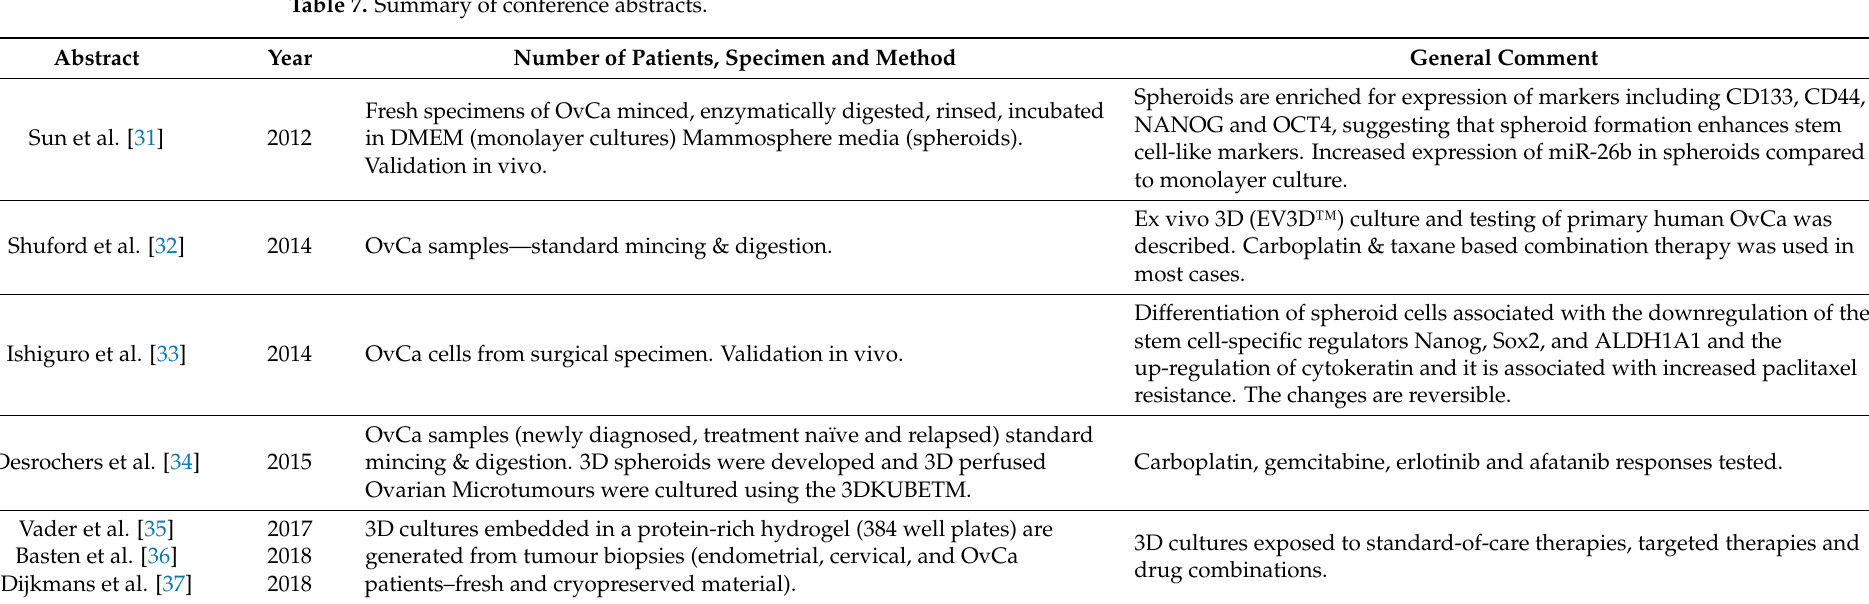
Table 7. Summary of conference